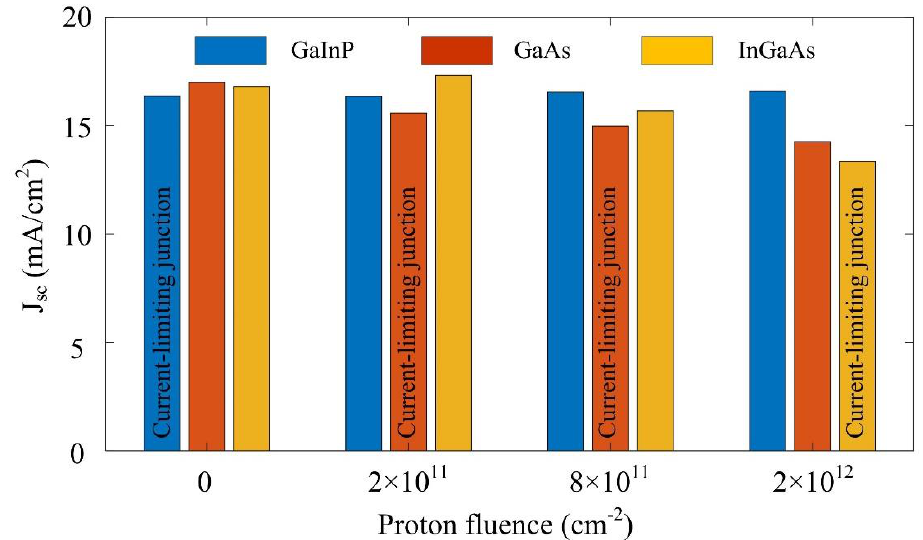
Figure 6. Comparison of J sc of GaInP, GaAs and InGaAs subcells before and after proton irradiation for IMM triple junction solar cells.